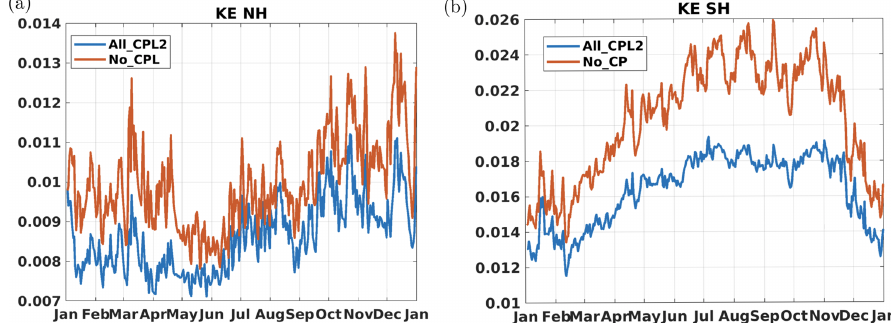
Figure 15. Time series of the spatially averaged surface kinetic energy (m 2 s − 2 ) for (a) the Northern Hemisphere and (b) the Southern Hemisphere.